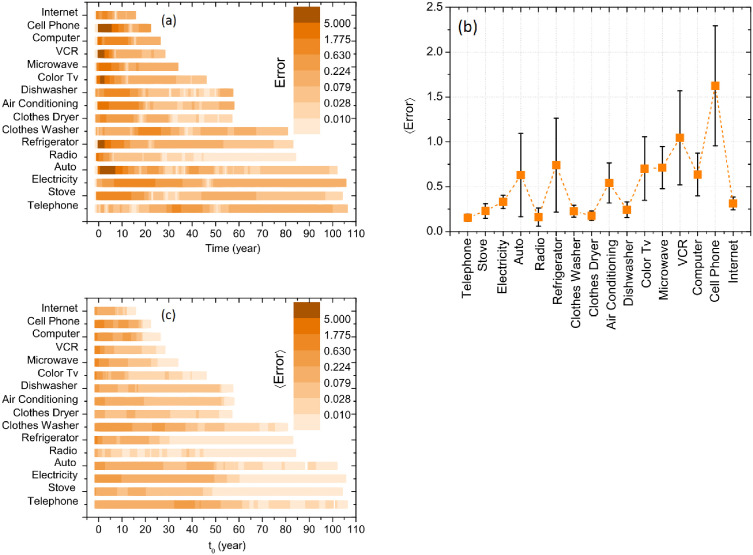
Quality of the data fits for each of the technologies analyzed, measured by the relative error between the empirical curves [21] and the analytical solution (Eq 19, after fitting.Errors are calculated considering the onset of the innovation, i.e.
n(0) = 0: (A) Dynamic relative error (Eq 21), (B) Average relative error (Eq 22). Vertical bars represent the standard deviation of the results and the dotted line is a guide for the eyes. (C) Average relative errors for different initial conditions n(t0) = n0. Initial conditions are different for each technology.